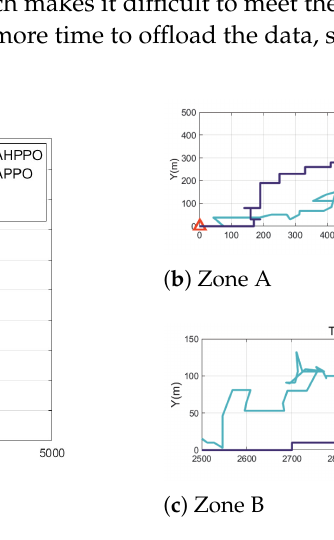
Figure 5. UAV trajectories with different schemes.